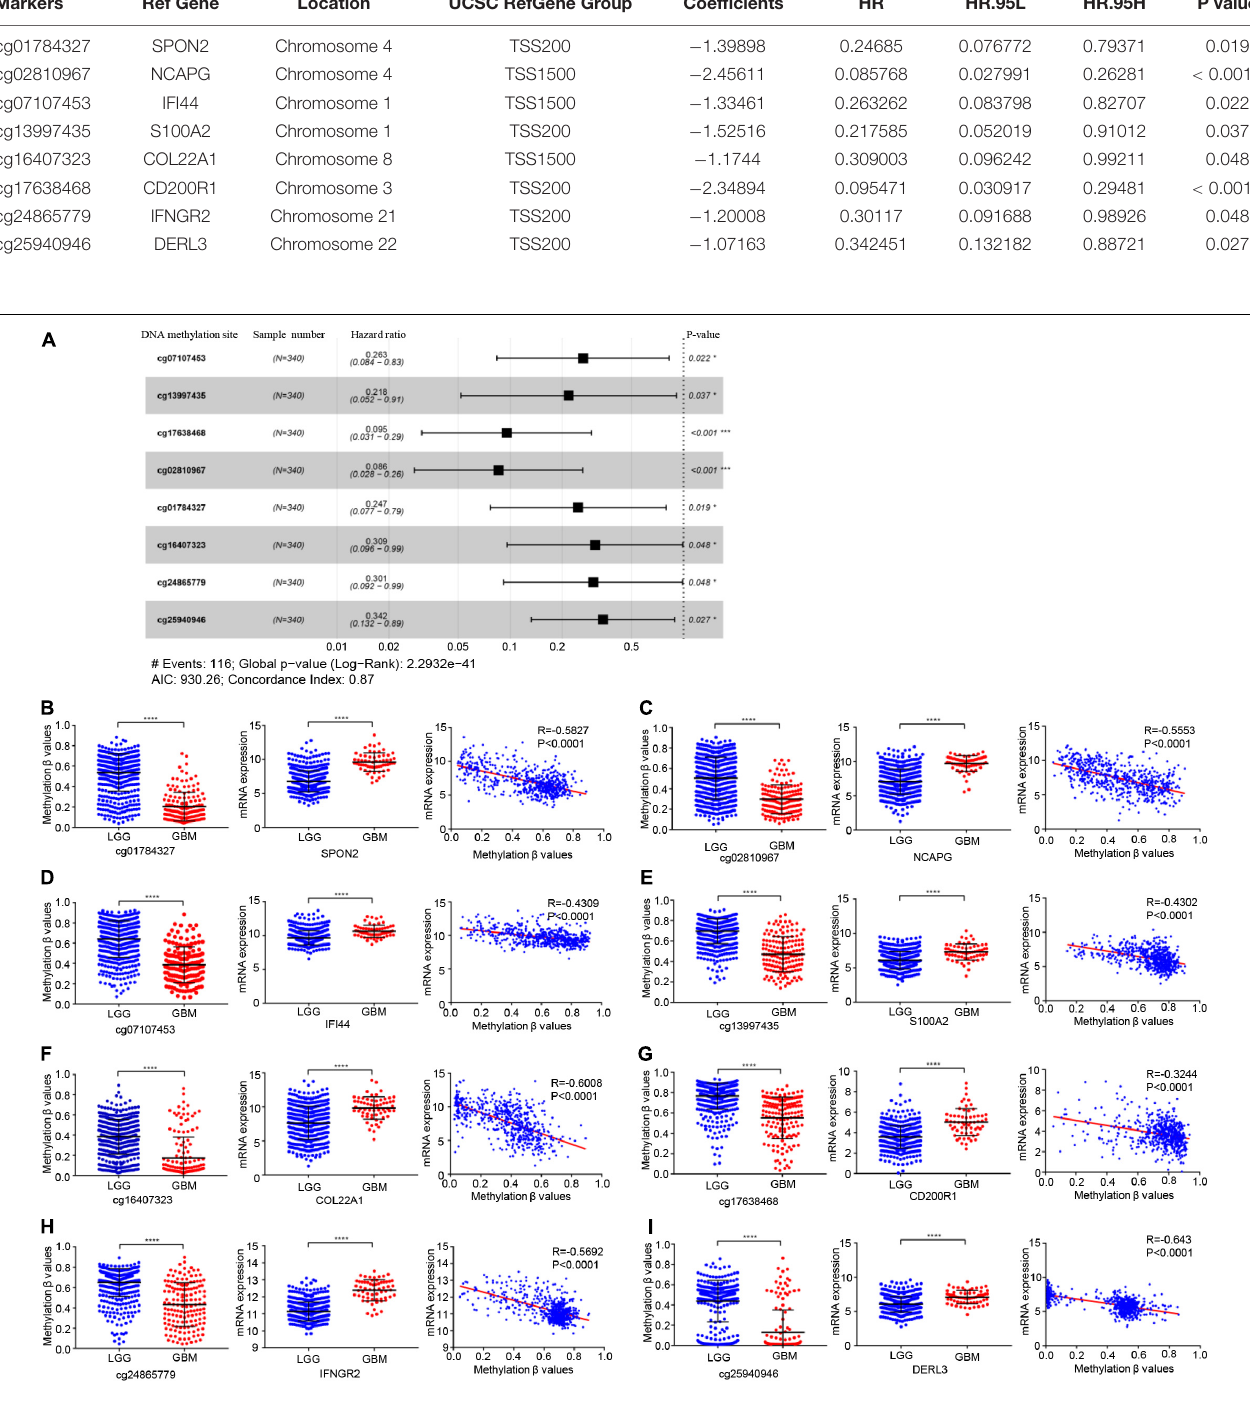
FIGURE 3 | Identification of key prognostic DNA methylation sites. (A) The forest plot of the hazard ratio of eight DNA methylation sites. DNA methylation degree of eight methylation sites and corresponding gene expression in low-grade glioma and GBM, and the correlation between DNA methylation degree and corresponding gene expression: (B) cg01784327 and SPON2, (C) cg02810967 and NCAPG, (D) cg07107453 and IFI44 (E) cg13997435 and S100A2, (F) cg16407323 and COL22A1, (G) cg17638468 and CD200R1, (H) cg24865779 and IFNGR2, (I) cg25940946 and DERL3. Abbreviations: ns, P > 0.05, * P < 0.05, *** P < 0.001, **** P <